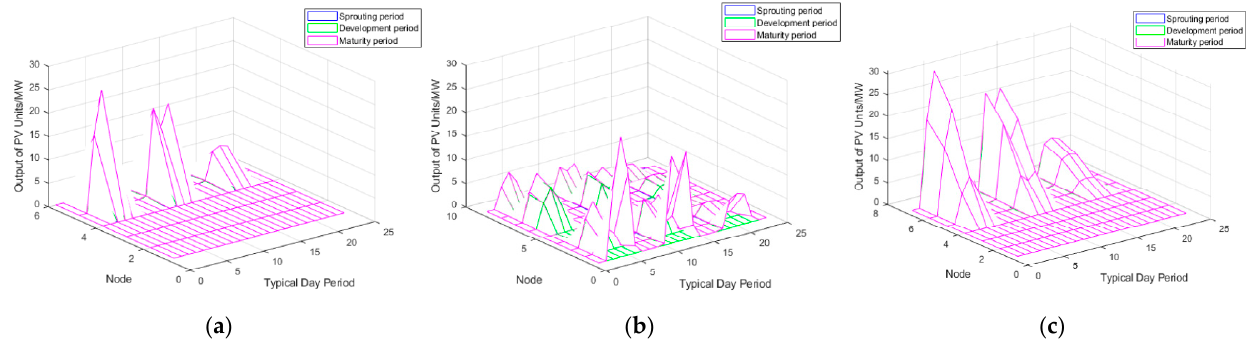
Figure 6. Output of PV unit at each typical stage of the system: ( a ) transmission network; ( b ) distribution network 1; ( c ) distribution network 2. Table 6. Collaborative planning scheme for wind-PV-ESS of transmission and distribution network in different